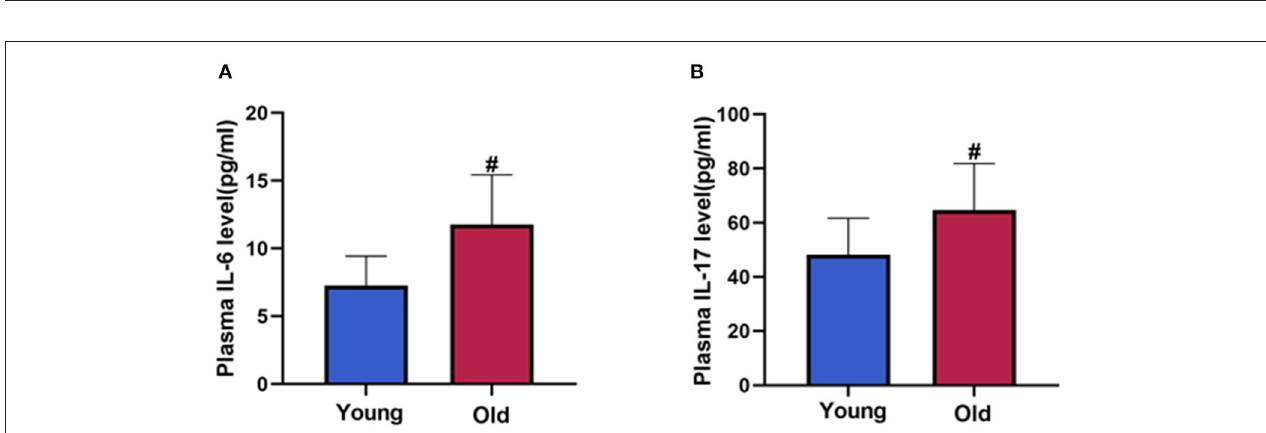
FIGURE 3 | IL-6 and IL-17 level between young and old-aged group. Patients in old-aged group had higher levels of IL-6 (A) and IL-17 (B) than young patients. Data are given as mean ± SD. # P < 0.05 vs. young group.